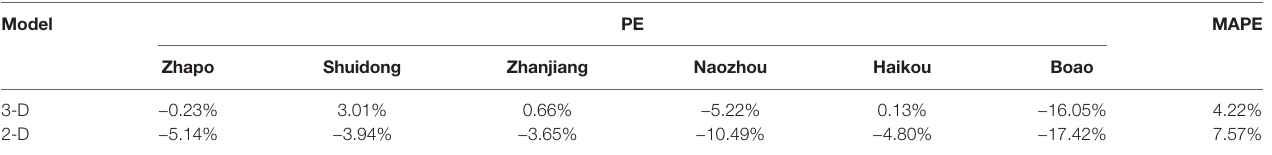
TABLE 2 | PEs of peak surge between model simulation and observation under 3-D and 2-D models. Model PE MAPE